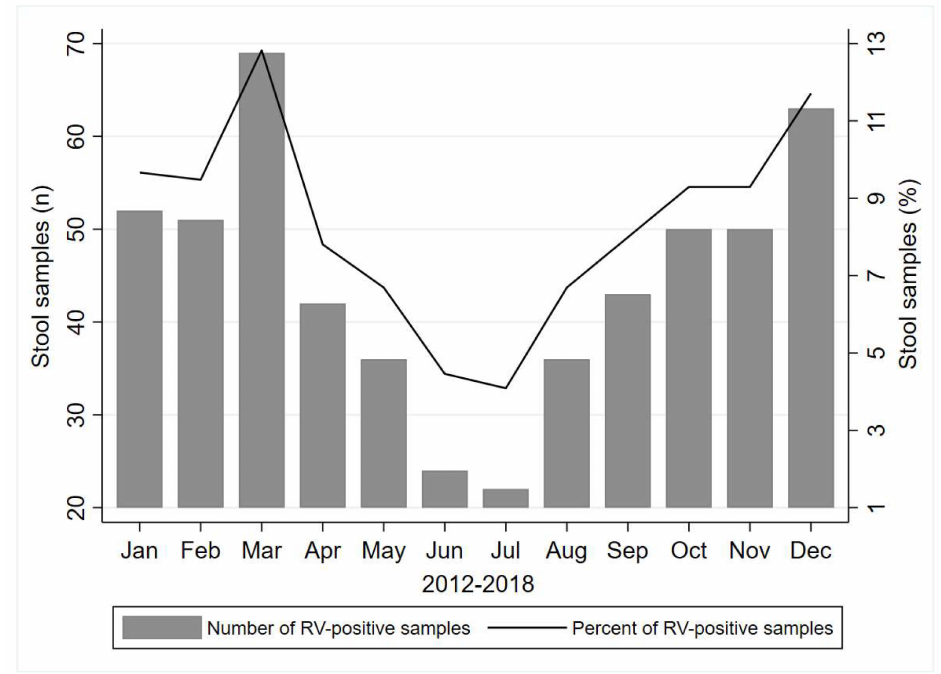
Figure 1. Number of RV-positive samples by month of registration, during the period 2012–2018 in Vojvodina province,